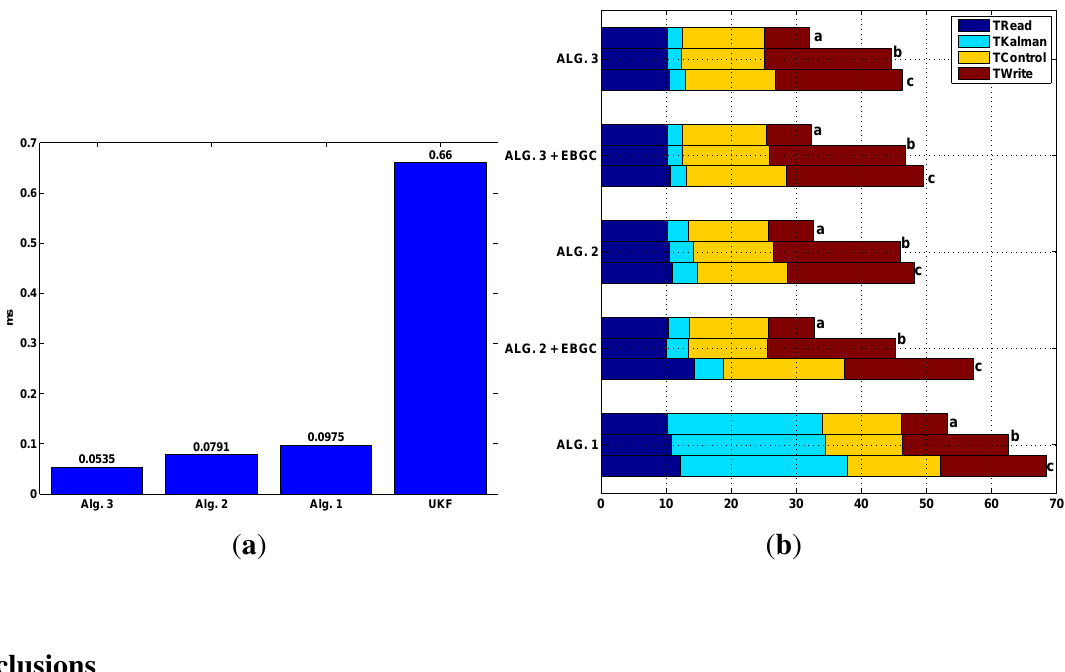
Figure 13. Run Time tests. ( a ) Mean Execution time test, PC simulation; ( b ) Execution time test, experimental results onboard the LEGO